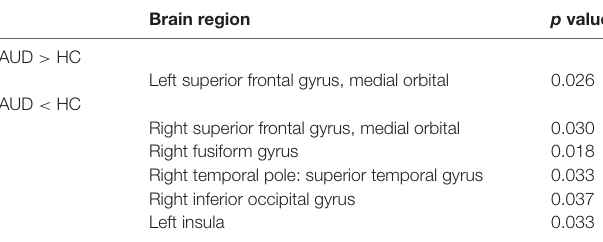
TABLE 2 | Abnormal nodal efficiency in the AUD group as compared with the HC group.